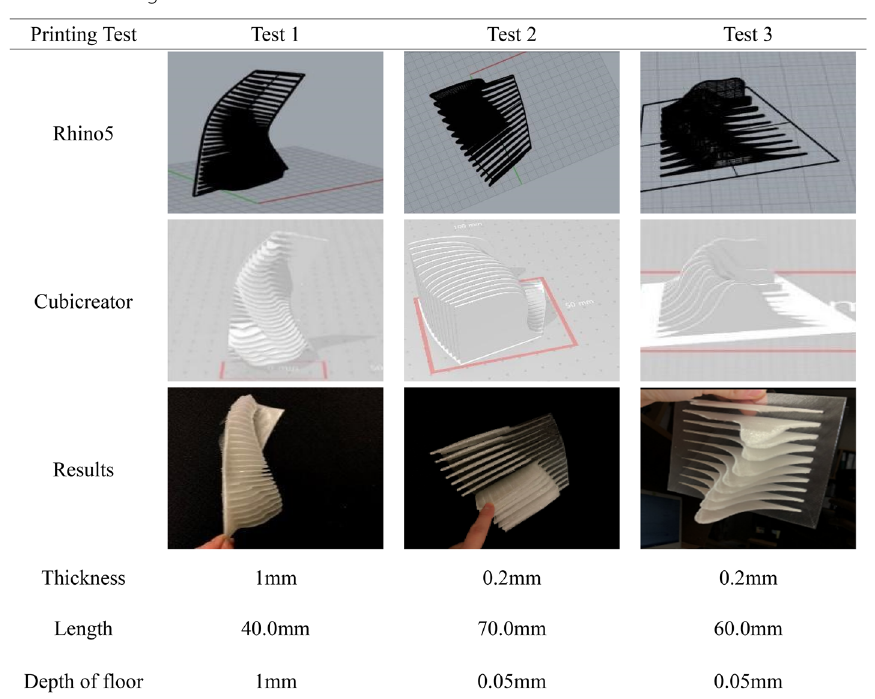
Table 7 Printing test of ‘Motif